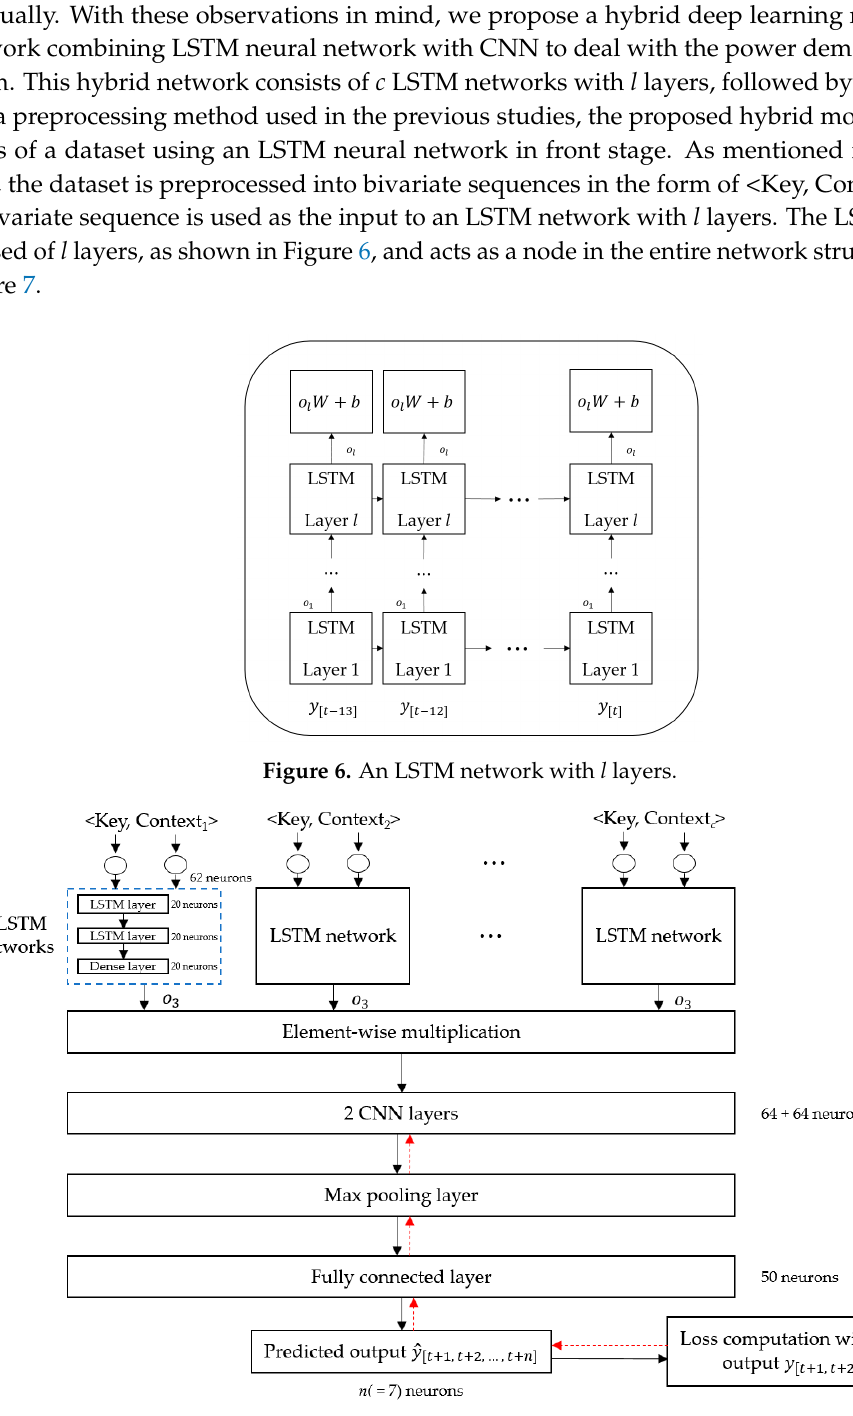
Figure 7. Structure of the proposed hybrid model. The feature set output from the c LSTM networks is used as input to the CNN.